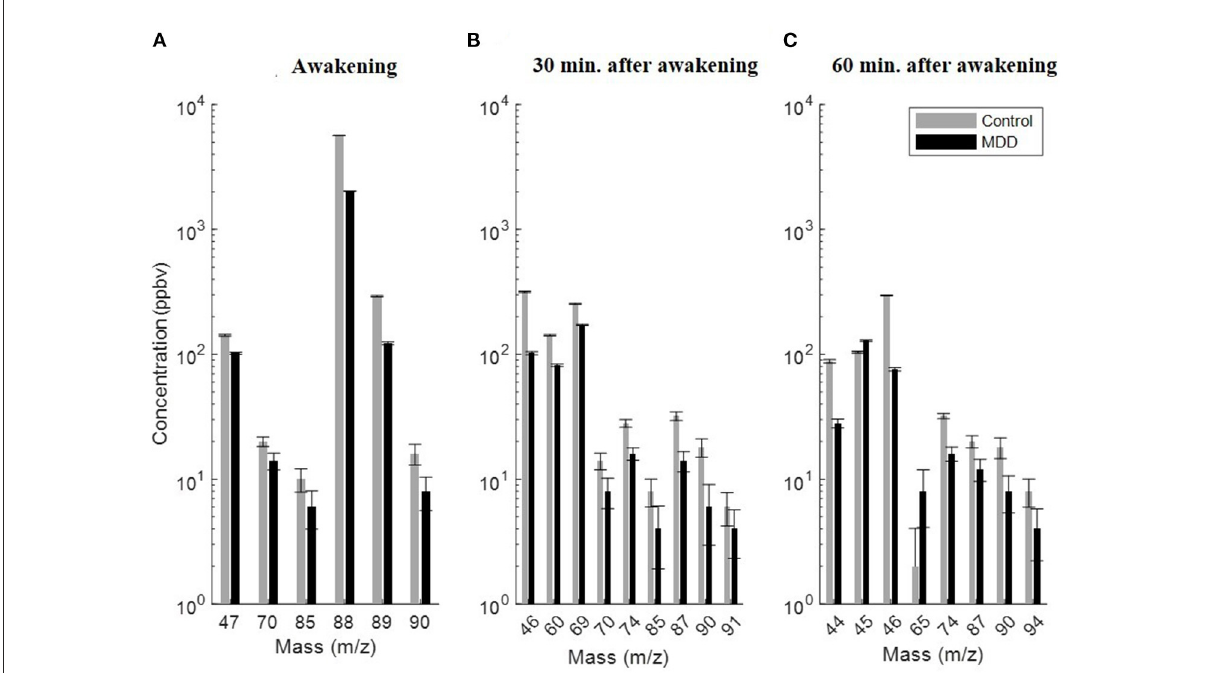
FIGURE1 Significant exhaled VOCs discriminating between patients with major depression (black) and healthy controls (gray) after exclusion of smoking VOCs, compounds with inter- and intra-variability and compounds available in lower than 70% of samples. (A) At awakening, (B) 30min after awakening, and (C) 60min after awakening. All exhaled VOCs were decreased in the breath of MDD patients except VOCs at acetaldehyde at m/z = 45 and ethanol isotope at m/ = 65. All concentrations of the VOCs are plotted in median and geometric standard